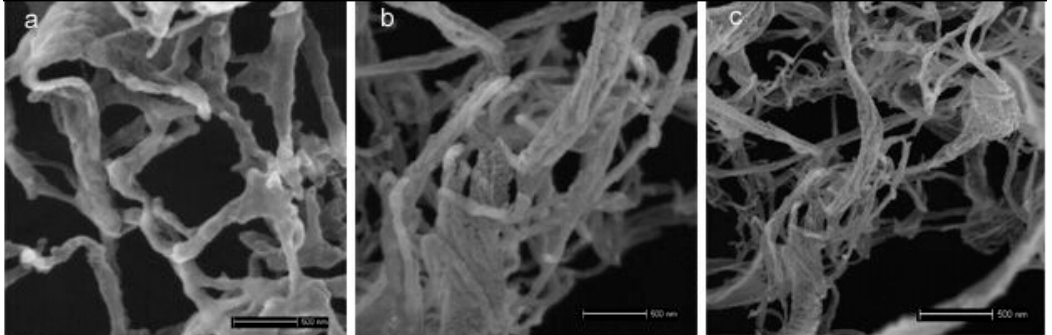
Figure 3. FE-SEM images: ( a ) ACNC-20 °C, ( b ) ACNC-30 °C, ( c ) ACNC-40 °C.